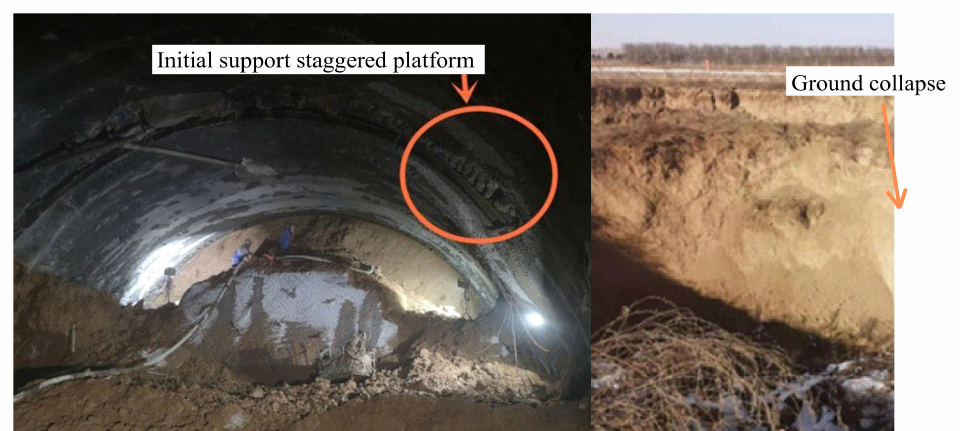
Figure 3. Problems caused by large deformation of